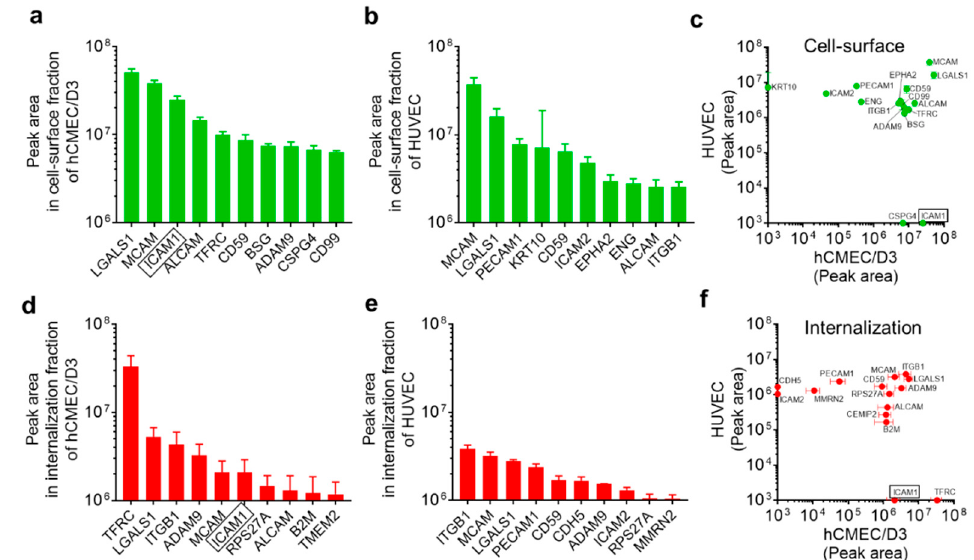
Figure 4. The top 10 highest expressing “biotinylated cell-surface proteins” and “biotinylated endocytic cell-surface proteins” in hCMEC/D3 cells and HUVECs. ( a , b ) Top 10 identified “biotinylated cell-surface proteins” in hCMEC/D3 cells ( a ) and HUVECs ( b ). ( c ) A total of 16 “biotinylated cell-surface proteins” were identified from among the top 10 identified “biotinylated cell-surface proteins” in either hCMEC/D3 cells or HUVECs. The relationship between the peak areas of the 16 “biotinylated cell-surface proteins” in hCMEC/D3 cells and HUVECs is shown. ( d , e ) Top 10 identified “biotinylated endocytic cell-surface proteins” in hCMEC/D3 cells ( d ) and HUVECs ( e ). ( f ) A total of 15 “biotinylated endocytic cell-surface proteins” were identified from among the Top 10 identified “biotinylated endocytic cell-surface proteins” in either hCMEC/D3 cells or HUVECs. The relationship between the peak areas of the 15 “biotinylated endocytic cell-surface proteins” in hCMEC/D3 cells and HUVECs is shown. Each datapoint represents the means ± SD ( n = 3).